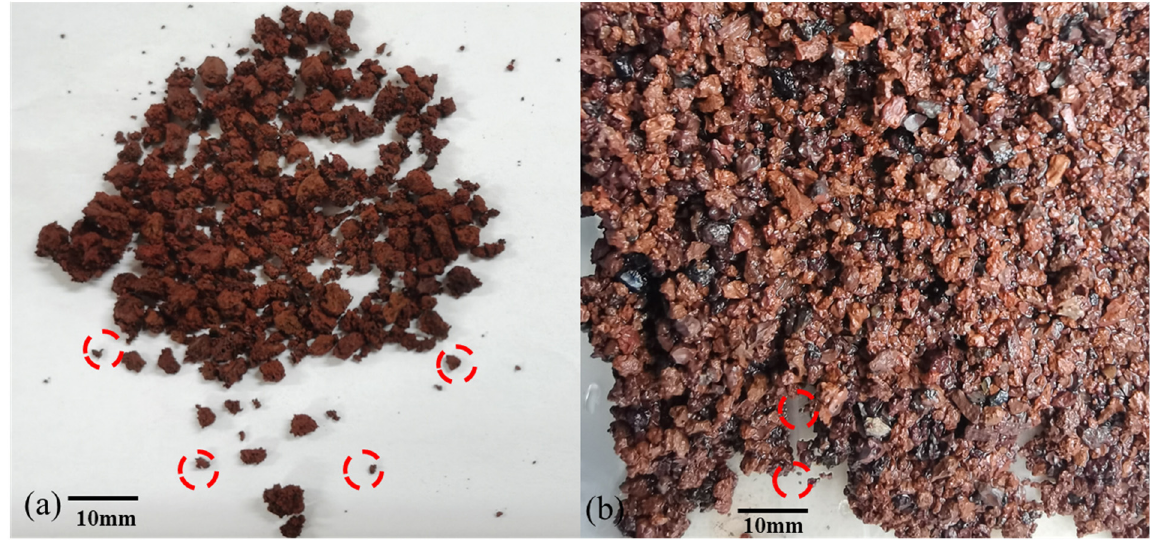
Figure 19. Photos of volcanic soil after shear test: ( a ) 2–5 mm-0.7–400 kPa test sample; ( b ) 0.5–2 mm– 0.7–400 kPa test sample.